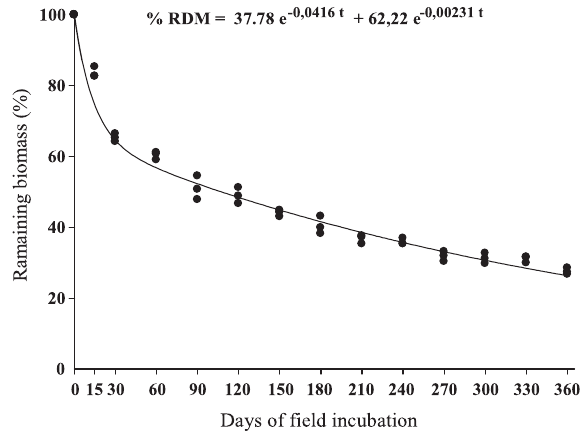
Figure 2. remaining poultry litter dry matter (%) after periods up to one year of field incubation in litter bags.